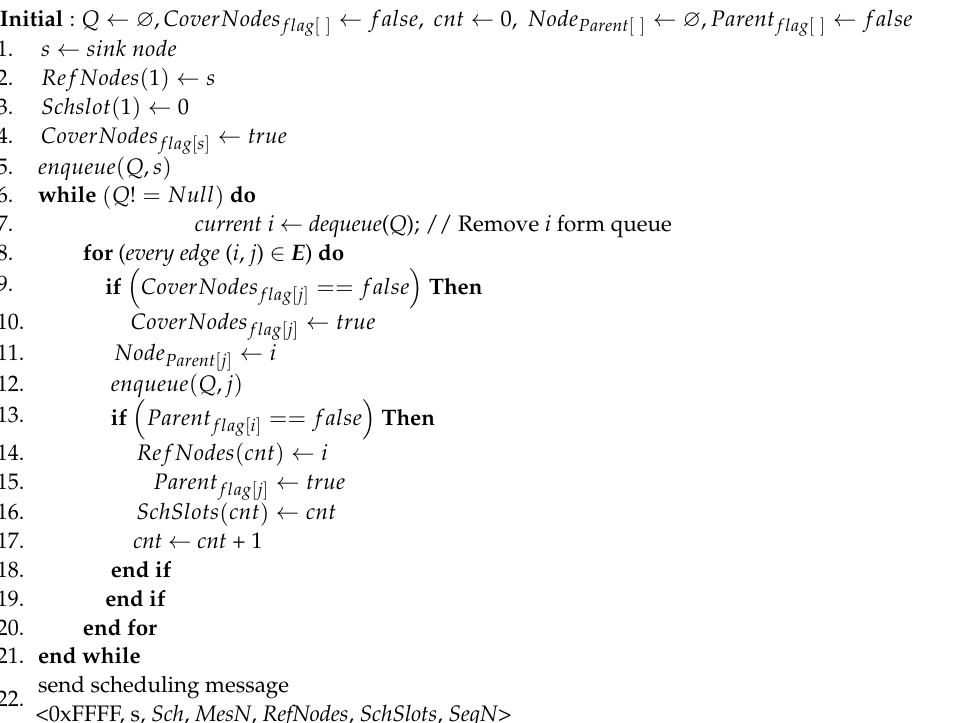
Algorithm 1 : LPSRS pseudo-code for the scheduling process (sink node